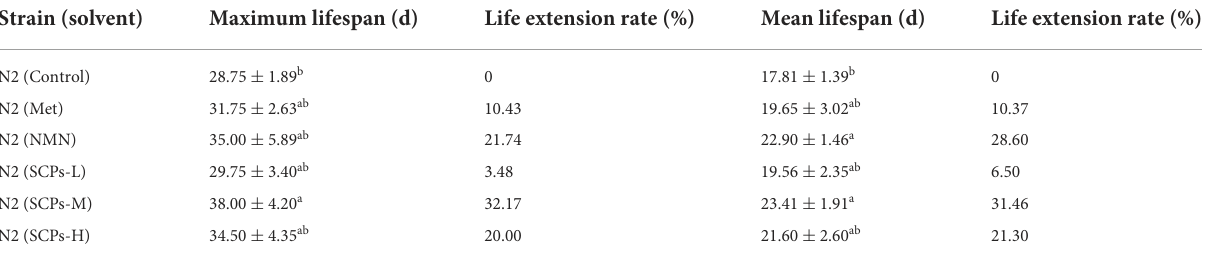
TABLE 2 Effects of SCPs on the life span of wild-type C. elegans under normal conditions. Strain (solvent) Maximum lifespan (d) Life extension rate (%) Mean lifespan (d) Life extension rate